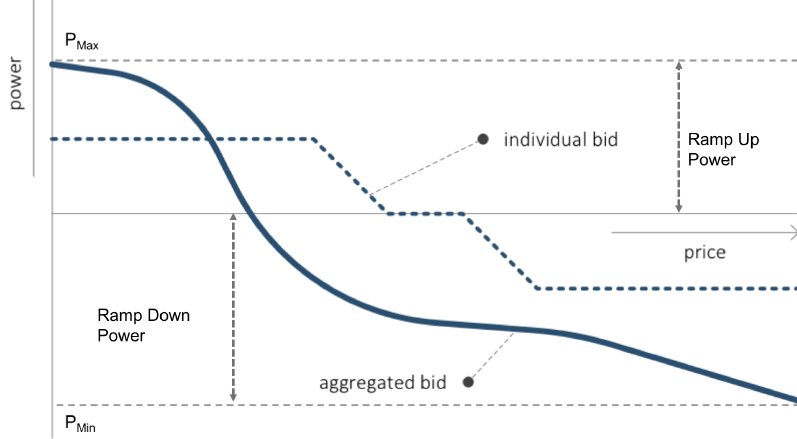
Figure 3. Aggregated bid for the PowerMatcher technology